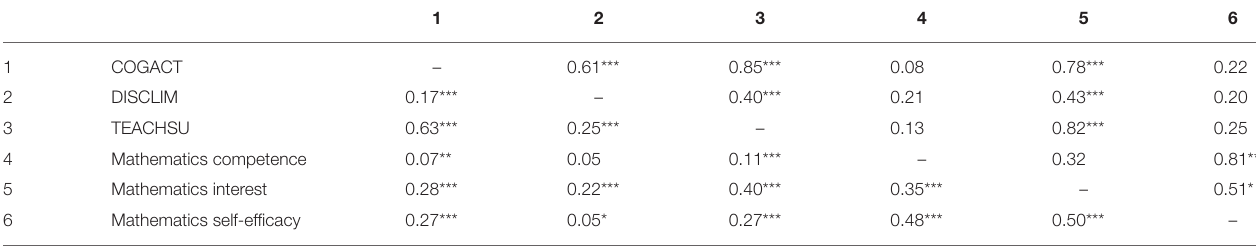
TABLE 1 | Intercorrelations at the class level (above the diagonal) and at the individual level (below the diagonal) for the Gymnasium.